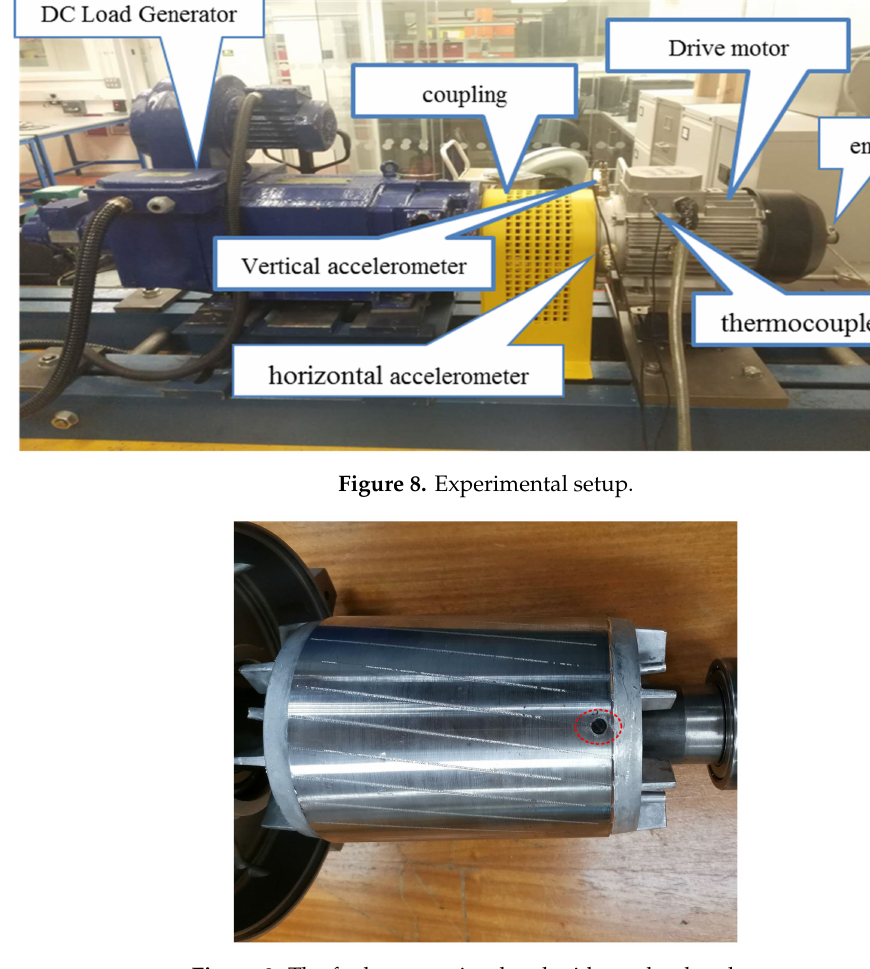
Figure 9. The faulty rotor simulated with one bar